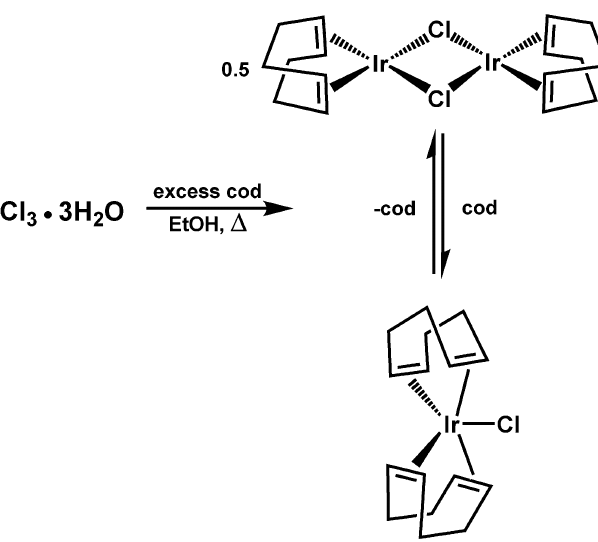
Figure 1 Reaction scheme showing the formation of the mixture of [Ir(cod)( (cid:2) - Cl)] 2 and IrCl(cod) 2 . As the ethanol is removed under vacuum the solution becomes rich in cod, which drives the formation of IrCl(cod) 2 . Loss of cod regenerates the